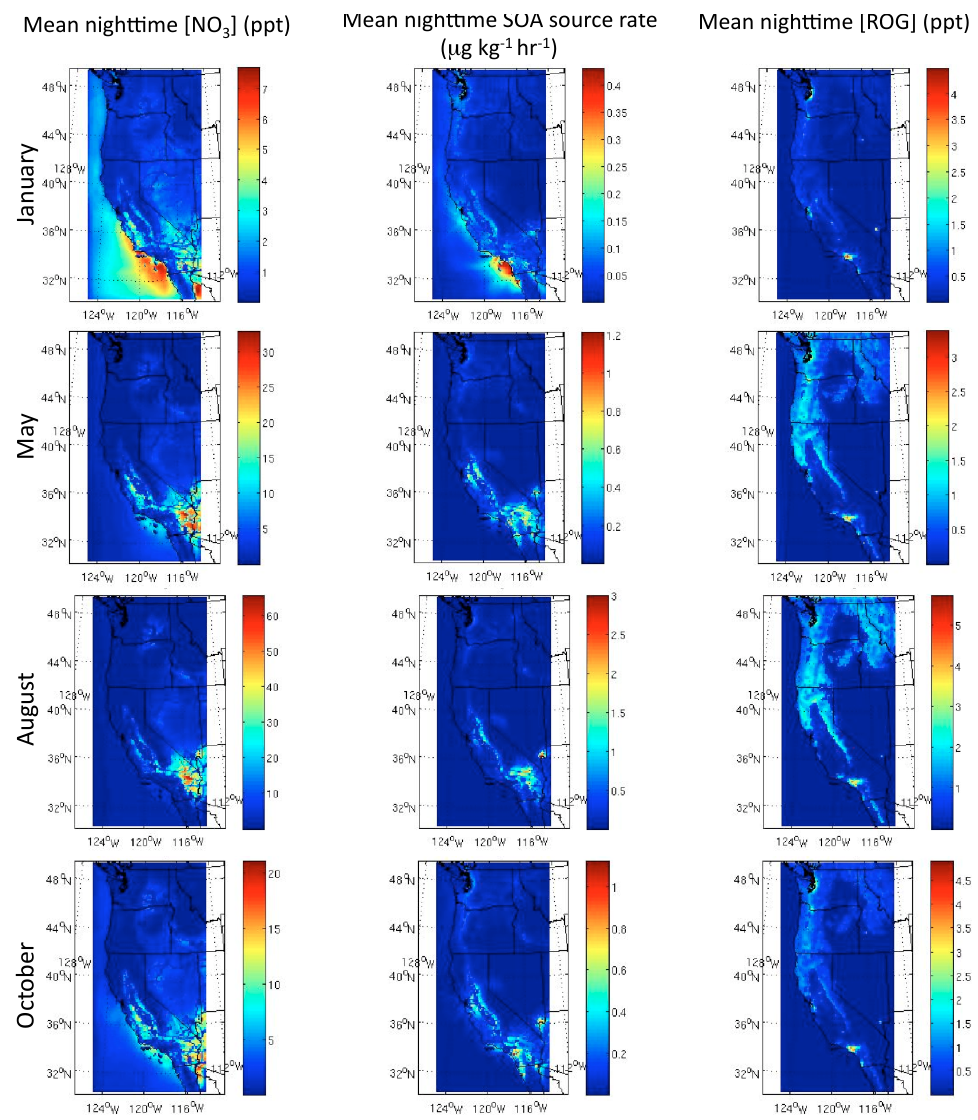
Fig. 4. Seasonal pattern of NO 3 -initiated SOA source rate (center panels), which is calculated based on the hourly nighttime surface [NO 3 ] map (left panels) and surface reactive organic gases ([ROG]) (right panels), which is a sum of isoprene (ISOP), internal (OLI) and external (OLT) olefins. The monthly average of these hourly calculations is shown here.